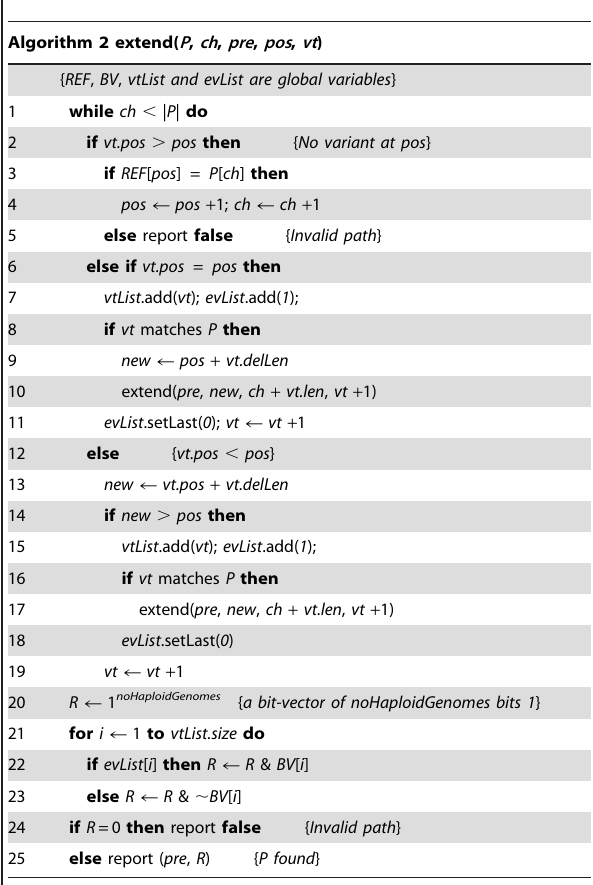
Table 2. Pseudocode of the algorithm extending the found seed in the basic search.